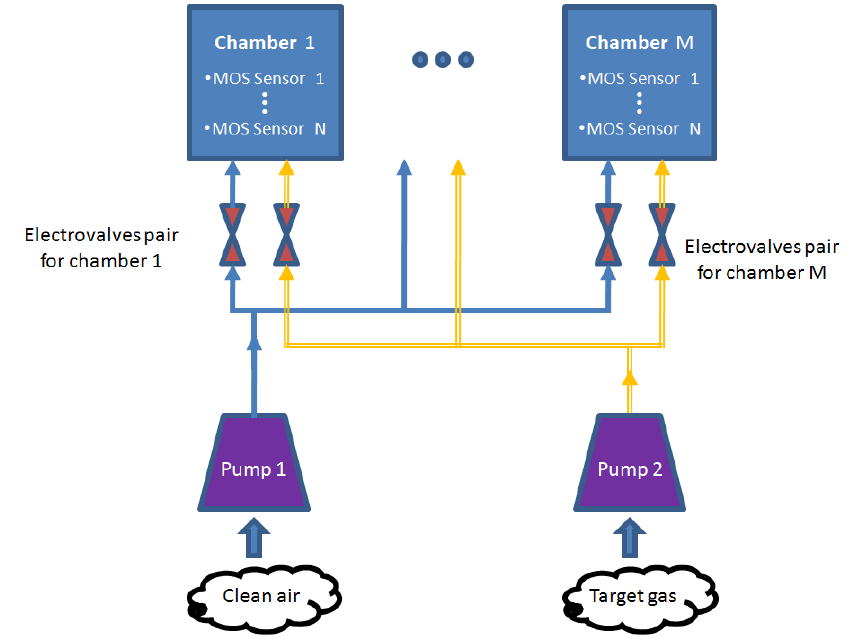
Figure 3. A functional schematic diagram of the MCE-nose. There are two pumps: one aspirating clean air and the other the target gas. At each time, only one chamber is receiving the target gas while the other M-1 chambers are being purged with clean